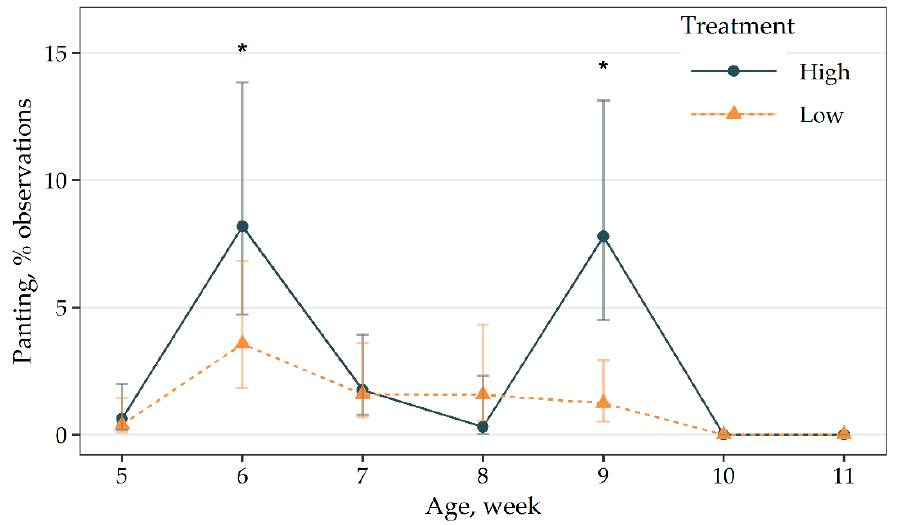
Figure 4. Means ( ± 95 CI) of panting events for outdoor stocking density treatment (high: 0.5 m 2 of pasture per bird; low: 2.5 m 2 of pasture per bird) and age interaction effect. No birds were observed panting during weeks 10 and 11 so these weeks were removed from the analysis. * = means within a week are different after Tukey’s adjustment, p ≤ 0.01.